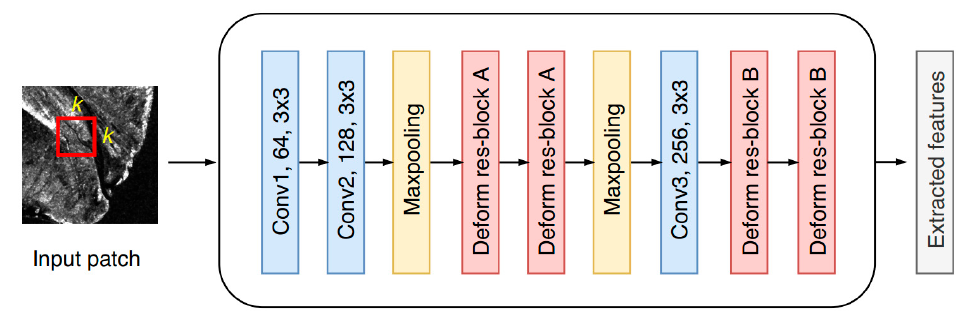
Table 3. Detailed information of the single-branch CNN.